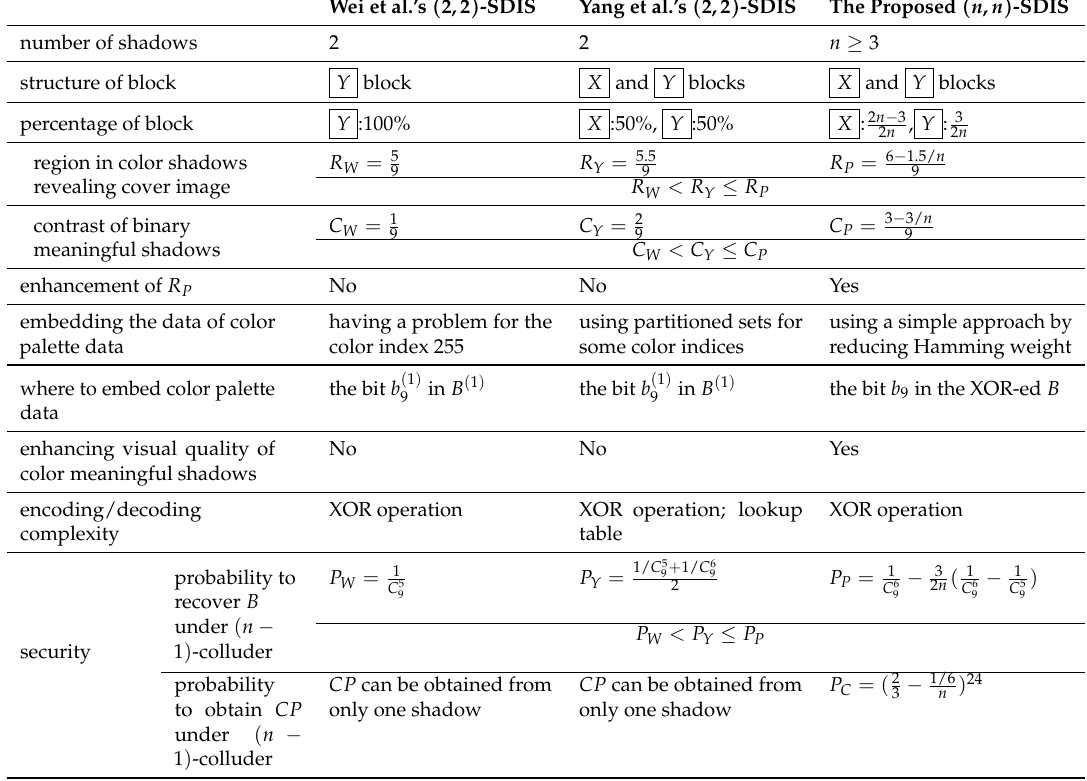
Table 2. Comparison of Three SDIS